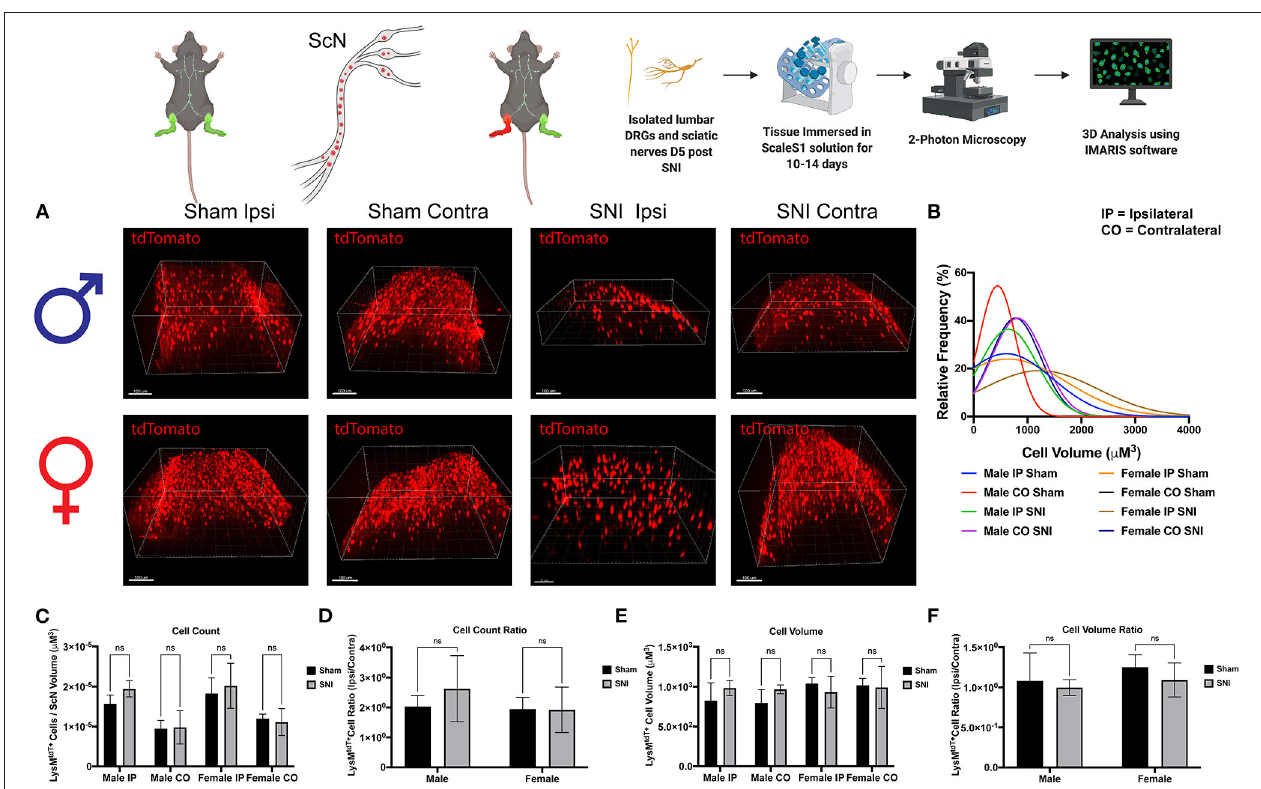
FIGURE 4 | Infiltration of LysM tdT + immune cells in the ScNs 5 days post-SNI. Male and female LysM-cre × tdTomato mice had ScNs harvested 5 days post-SNI. Tissues were processed and cleared using ScaleS1 solution for 10–14 days and imaged using 2-photon microscopy. (A) Representative images from male and female LysM tdT + (red; 1,100nm) ScNs ( n = 3). (B) Frequency distribution histogram comparing the frequencies of LysM tdT + cell volumes in control and injured male and female lumbar ScNs. (C) Quantification of LysM + immune cell infiltration in the lumbar ScNs 5 days post-SNI ( n = 3) in males and females. (D) Quantification of LysM tdT + macrophage infiltration in the lumbar ScNs 5 days post-SNI as a ratio of ipsilateral over contralateral ScN ( n = 3) in males and females. (E) Quantification of LysM tdT + macrophage volume in the lumbar ScNs 5 days post-SNI ( n = 3) in males and females. (F) Quantification of LysM tdT + macrophage cell volumes in the ScN 5 days post-SNI as a ratio of ipsilateral over contralateral ScN ( n = 3) in males and females. Scale Bar: 100 µ m. IP, Ipsilateral; CO, Contralateral. Made using